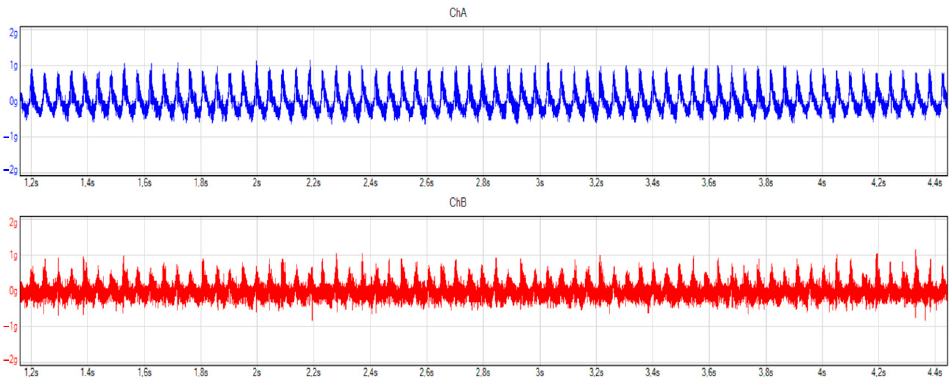
Figure 16. Vibrations in time domain after oil change, standstill, “D” selected. Blue and red colors mean the different considered and applied channels, during the measurement.